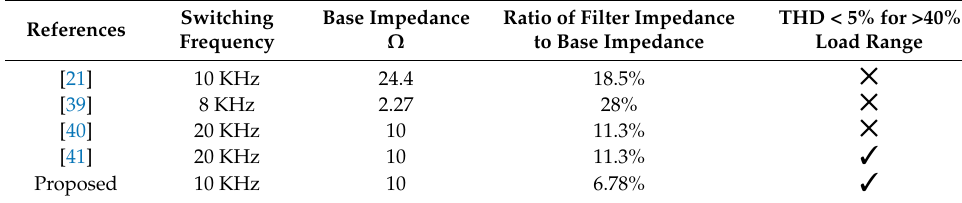
Table 4. Comparison of the filters used in earlier studies.